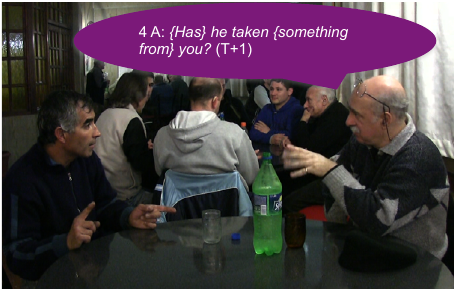
Figure 34. {Has} he taken {something from} you ?, Person A, on the right, interrupts B to ask a question related to what Person B has been referring before (line 1). Person B, on the left, holds his body still in the previous signing position (line 3), until Person A fixes the problem (line 4, figure 35).